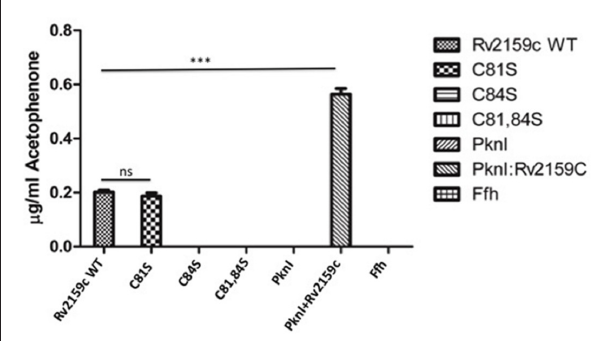
FIGURE 3 | Catalytic activity of Rv2159c and its mutants. Alkyl hydroperoxidase activity of Rv2159c variants (WT, C81S, C84S and C81,84S) were detected by measuring acetophenone using HPLC. The peroxidase activity of Rv2159c was also checked in the presence and absence of its substrate, PknI. No catalytic activity was observed with non-specific protein (Ffh), PknI alone and buffer control. One way ANOVA was performed. *** Indicates P < 0.001.